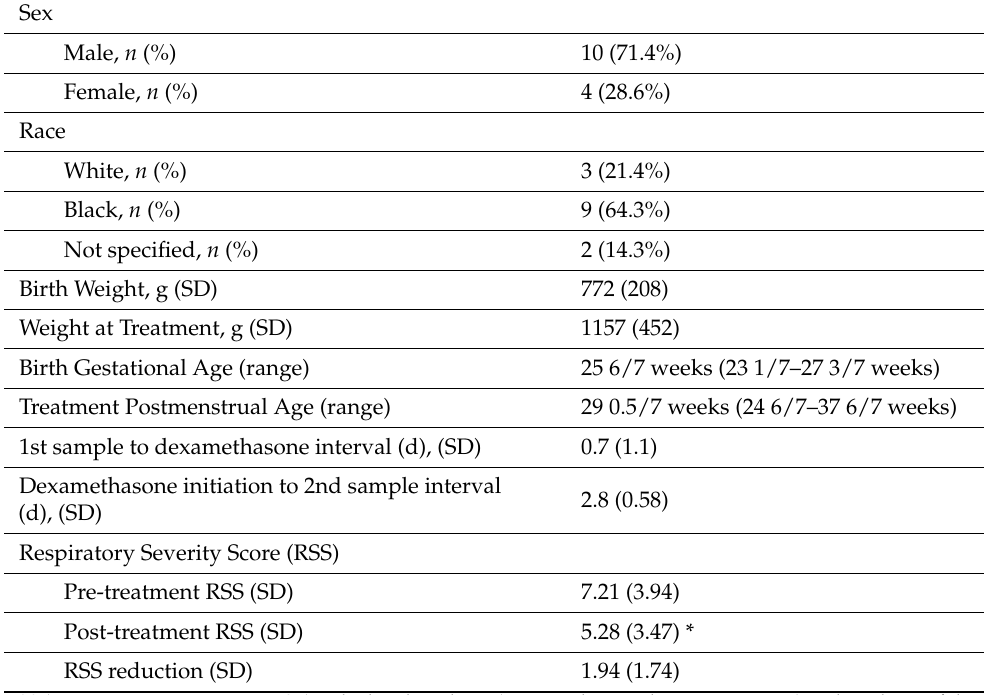
Table 1. Demographics of mechanically ventilated preterm infants prior to dexamethasone ( n =